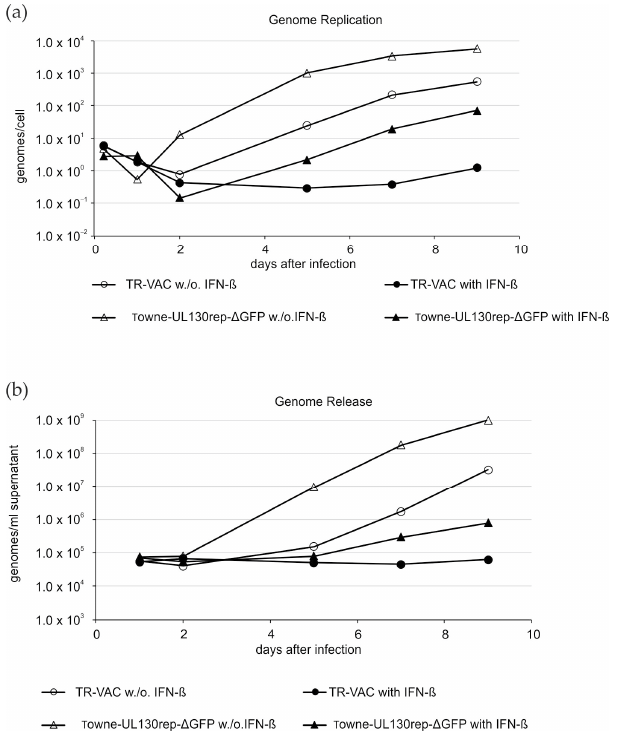
Figure 3. Sensitivity of genome replication and genome release of TR-VAC to IFN-ß treatment. ( a ) Quantitative PCR analysis of the viral genome replication in HFF, infected with TR-VAC or Towne-UL130rep-ΔGFP and cultured with or without IFN-ß. Lysates for analysis were collected at the indicated dpi. ( b ) Quantitative PCR analysis of the viral genome release from HFF, infected with TR-VAC or Towne-UL130rep- ∆ GFP and cultured with or without Shield-1. Cell culture supernatants for analysis were collected at the indicated dpi.